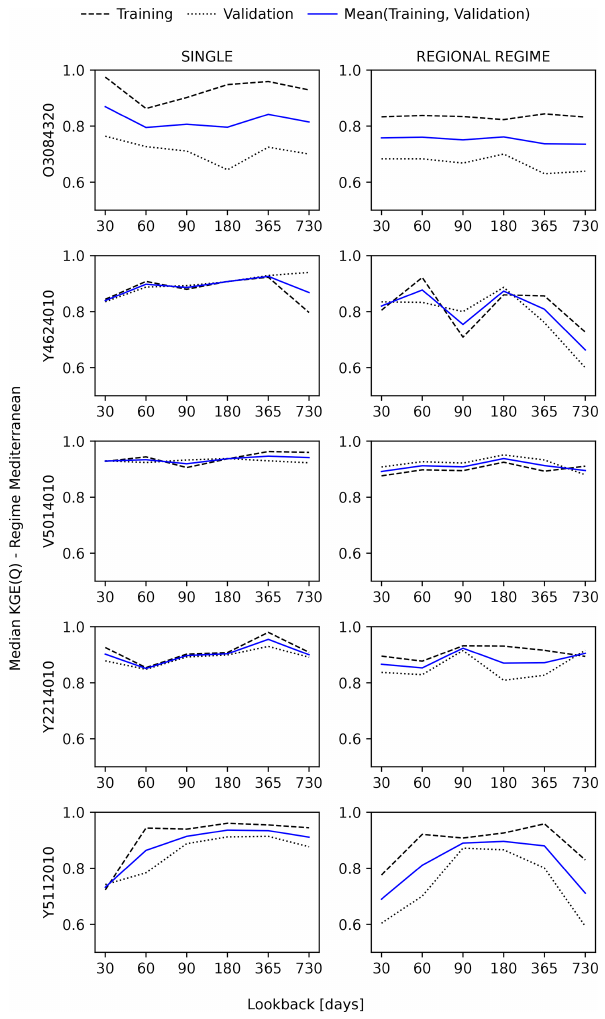
Figure 13. Five examples from the Mediterranean regime, each with a different lookback sensitivity